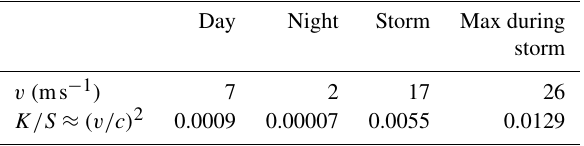
Table 3. Wind velocity in